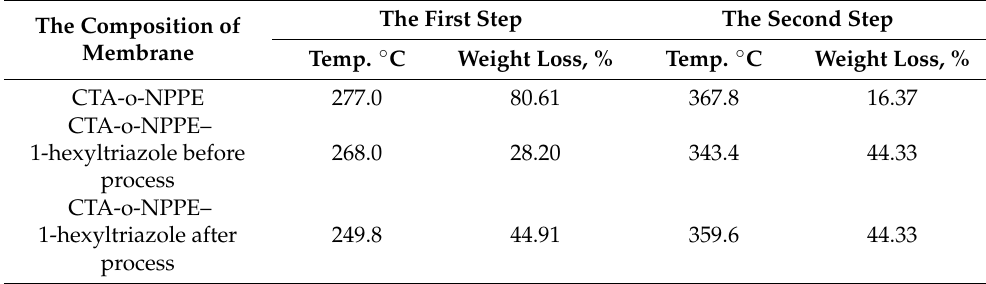
Table 3. Degradation temperatures and weight losses of CTA-o-NPPE membrane with 1-hexyltria- zole.